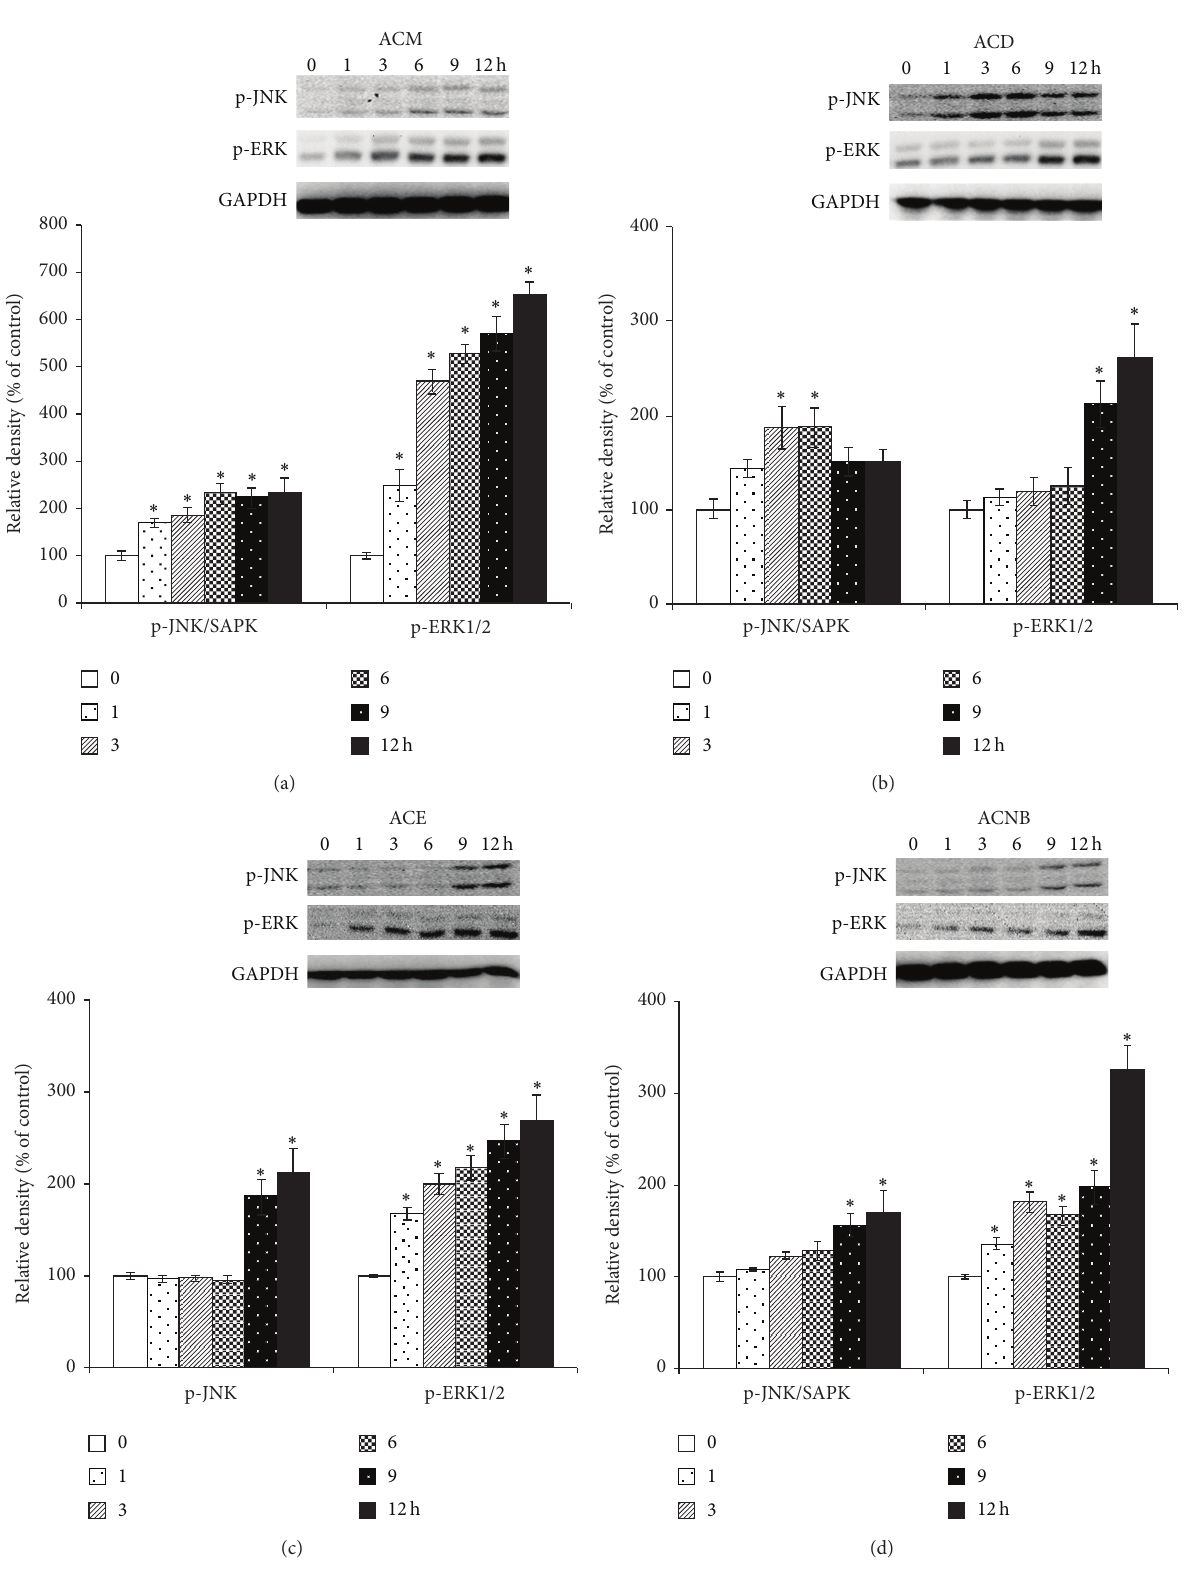
Figure 4: A. Communis extract and its different partition extracts downregulate the expression of MITF, p-CREB, and tyrosinase. The B16F10 cells treated with different extracts (a) ACM, (b) ACD, (c) ACE, and (d) ACNB. ∗ 𝑃 < 0.05 indicates significant difference from 0